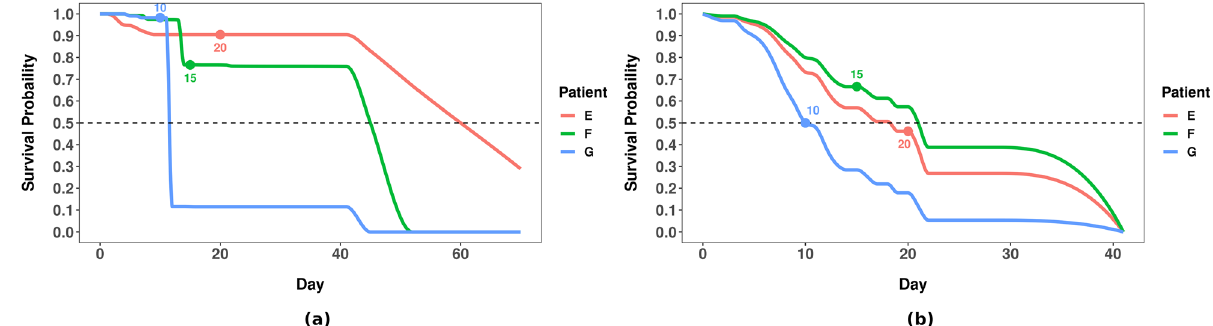
Figure 6. Individual survival curves of the same 3 randomly selected COVID-19 patients from dataset D2[d], for ( a ) RSF, and ( b ) GBCM-KP. Note that the actual death times are shown with solid “ • ” for each